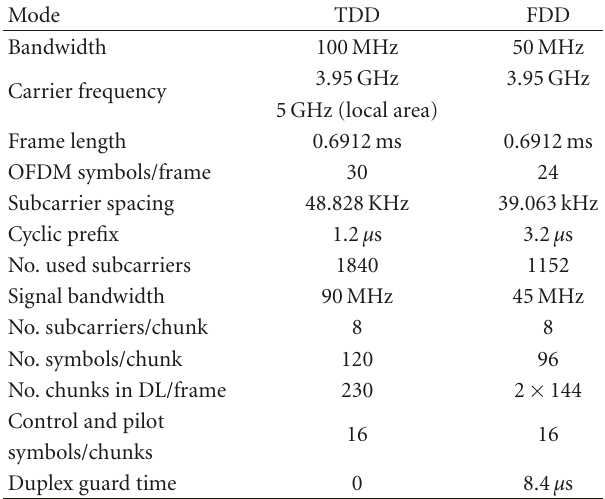
Table 5: WINNER OFDMA parameters for Downlink